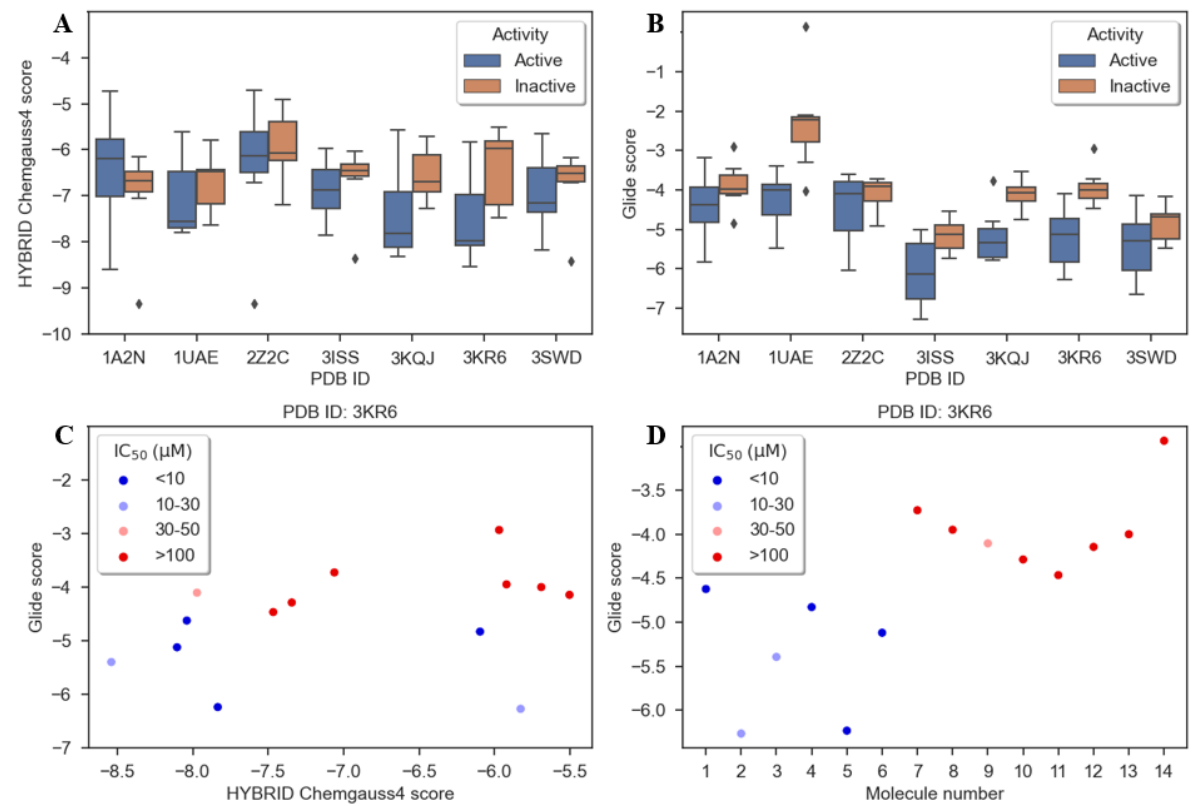
Figure 3. Docking results. ( A ) and ( B ) Boxplots of Hybrid and Glide docking scores of active and inactive compounds calculated for each enzyme separately; ( C ) scatterplot of Glide and Hybrid scores for each compound performed for the enzyme with PDB ID: 3KR6; ( D ) Glide scores per each compound for enzyme with PDB ID: 3KR6. IC 50 values in labels are inhibitory concentrations on MurA from E. coli .